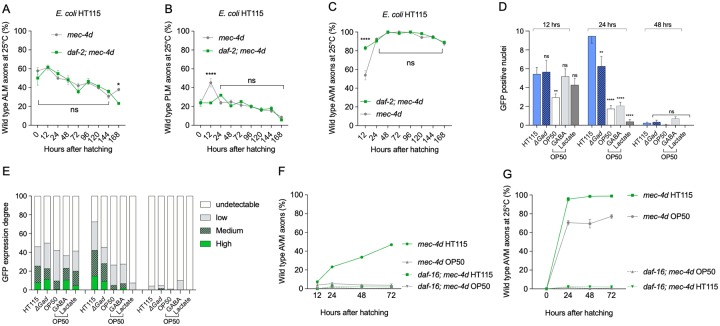
Effect of down-regulation of the insulin pathway on E. coli HT115–mediated neuroprotection.(A–C) Neuronal integrity of ALM (A), PLM (B), and AVM (C) neurons of daf-2(ts); mec-4d animals feeding on HT115 food. (D) Number of GFP-positive nuclei in DAF-16::GFP animals feeding on E. coli OP50 or HT115 during development. DAF-16::GFP is observed in the entire body. (E) Degree of GFP expression of animals in (D). (F and G) Time course of neuronal degeneration in daf-16; mec-4d animals at 20 °C (E) and 25 °C (F). ****P < 0.0001, **P < 0.005; ns. The underlying numerical data and statistical analysis for each figure panel can be found in S1 and S2 Datasets, respectively. ALM, anterior lateral microtubule; AVM, anterior ventral microtubule; DAF-2, ortholog of the insulin receptor; DAF-16, ortholog of the FOXO transcriptional factor; GABA, γ-aminobutyric acid; gad, glutamate decarboxylase enzyme gene; GFP, green fluorescent protein; mec-4d, mechanosensory abnormality protein 4; ns, not significant; PLM, posterior lateral microtubule.